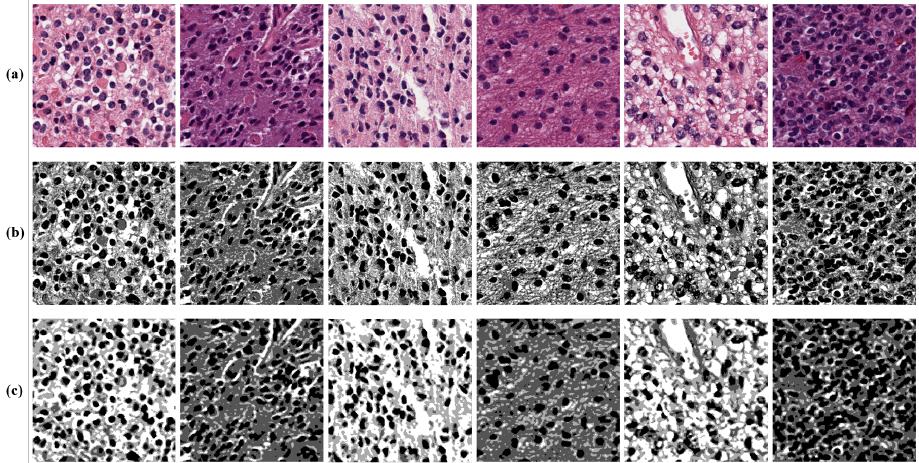
Figure 3. Examples of images obtained through k-means clustering and the segmentation results. ( a ) The samples of the segmentation network input. ( b ) The samples of k-means clustering results. ( c ) The samples of the mask images of the segmentation